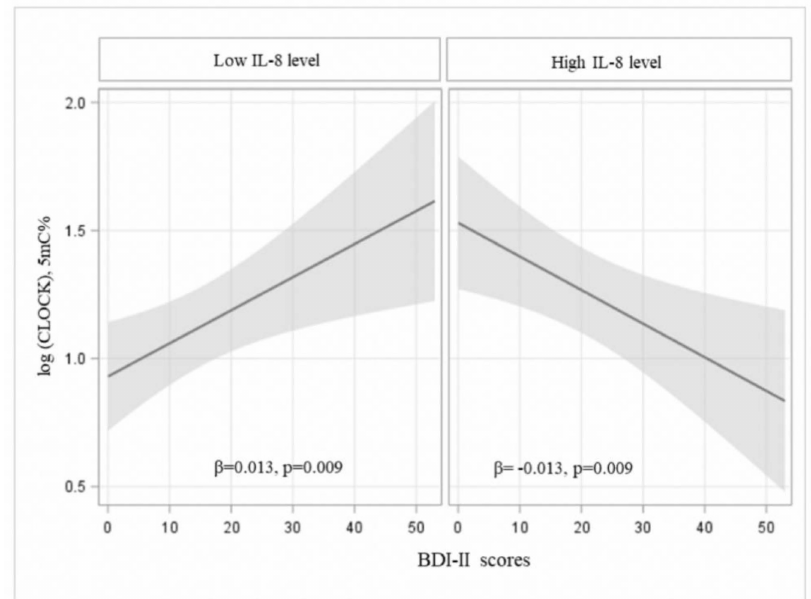
Figure 3. Association of BDI-II scores with methylation of CLOCK gene according to the changes of IL-8 plasma levels. Multivariable regression models applied to logarithmic transformation of clock gene, adjusted for Homa-IR index, percentage of neutrophils, homocysteine plasma level, position of methylation, vitamin D deficiency, IL-8, interaction between BDI-II score and IL-8. The estimates in the plot are calculated at mean level of continuous covariates and reference level of categorical variables (third position, no vitamin D deficiency). Low and high levels of IL-8 refers to 5 ◦ and 95 ◦ percentiles of its distribution (IL-8 low = 4.2 pg/mL, IL-8 high = 18